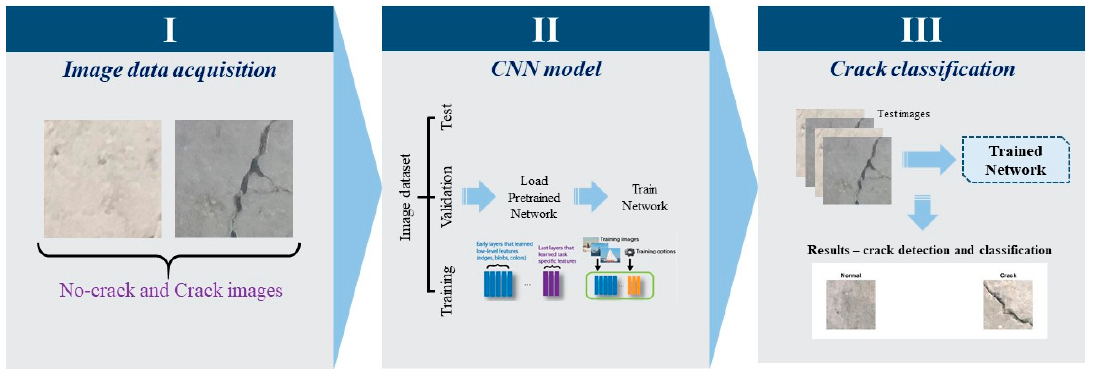
Figure 1. Scheme of the crack detection model.